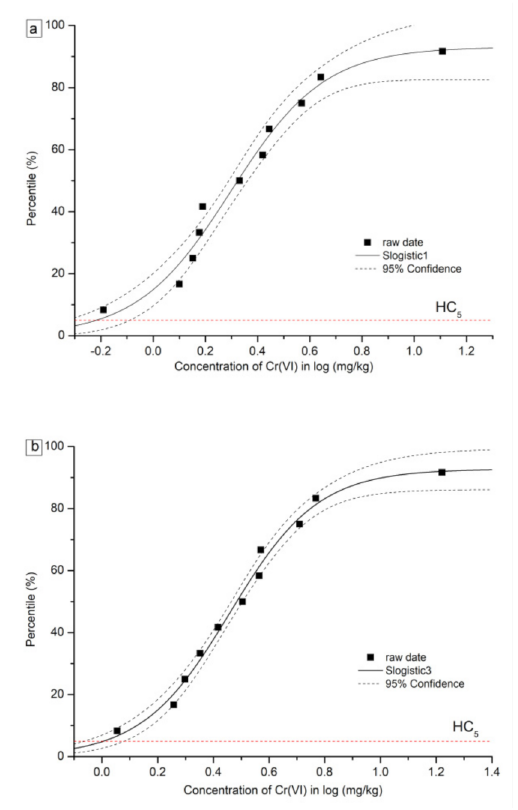
Figure 3. Curves of species sensitivity distribution for Cr (VI) based on ( a ) EC 10 , ( b ) EC 20 .